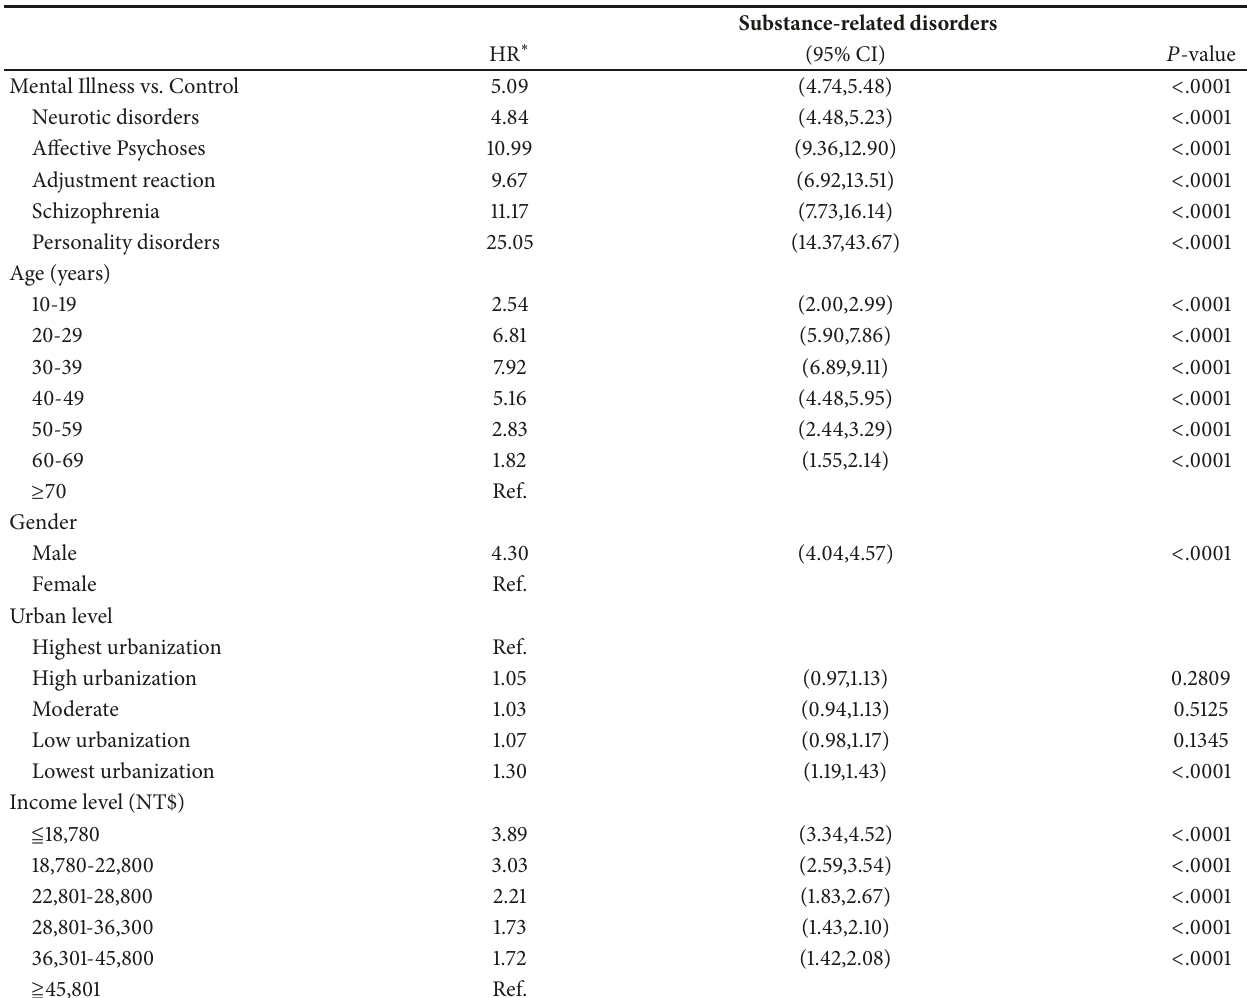
Table 3: Estimated hazard ratio of the subsequent onset of substance-relateddisorders for mental illness compared to those without, adjusted for age, gender, urban level, and income level